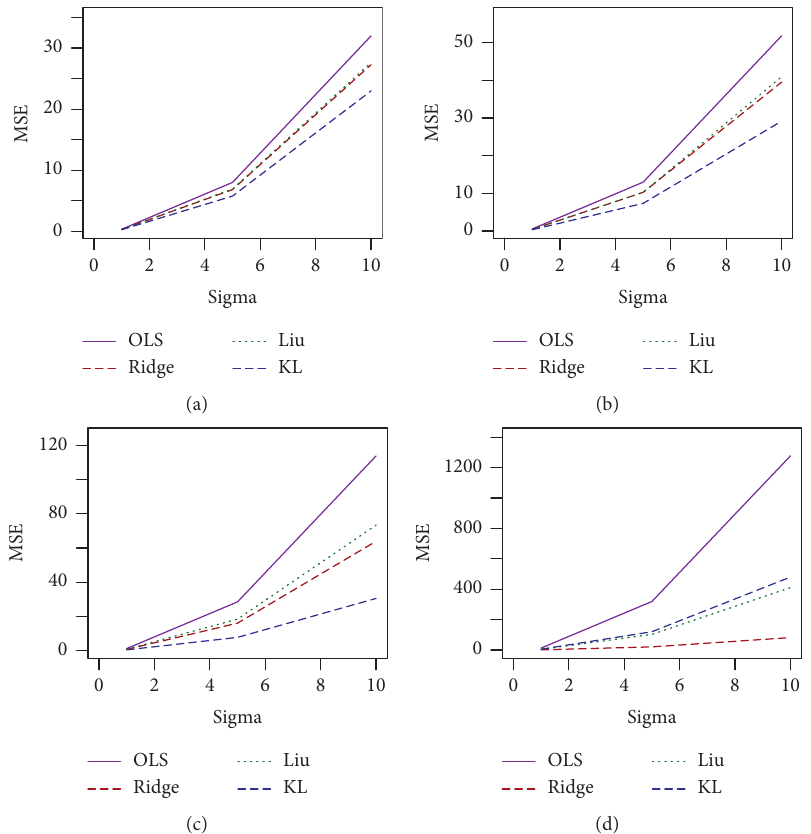
Figure 3: Estimated MSEs for n � 30, d � 0.5, and different values of rho and sigma. (a) n � 30, p � 3, d � 0.5, and rho � 0.70. (b) n � 30, p � 3, d � 0.5, and rho � 0.80. (c) n � 30, p � 3, d � 0.5, and rho � 0.90. (d) n � 30, p � 3, d � 0.5, and rho �